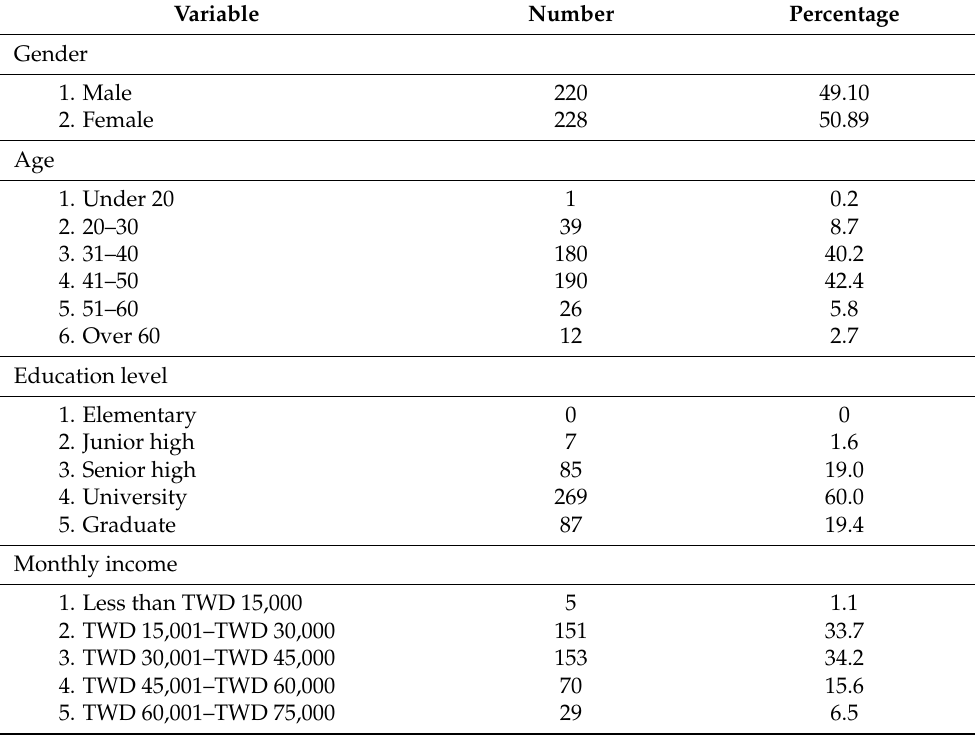
Table 2. Demographic information of the respondents (N =